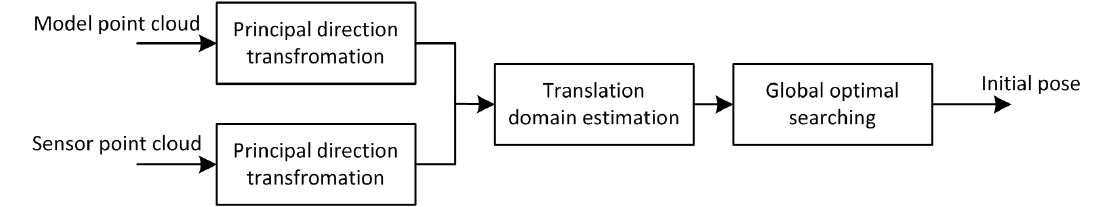
Figure 3. The framework of the pose initial acquisition method.